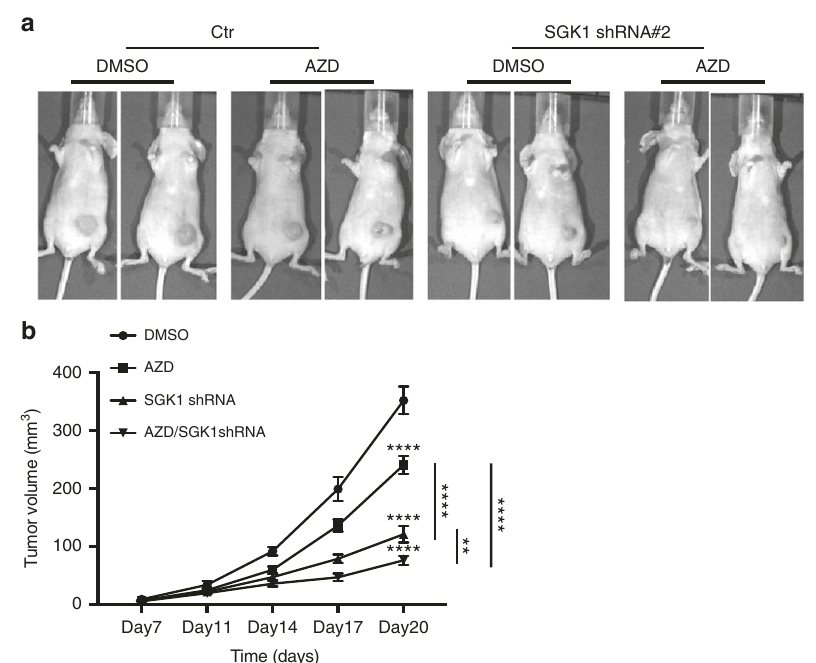
Fig. 9 Effect of combining SGK1 knockdown and Src inhibitor treatment on tumor growth. a Representative images of tumors. 2 × 10 5 MDA-MB-231 cells stably transfected with tetracyclin-inducible SGK1 shRNA#2 or empty vector control were injected orthotopically into the fourth mammary fat pad of BALB/c nude mice. Doxycyclin and AZD0530 (AZD) treatment was started 1 day later. Doxycycline was administered in the food and AZD was administered by oral gavage daily at 50 mg/kg. Tumors were allowed to grow for 20 days. Representative images of two tumors for each group are